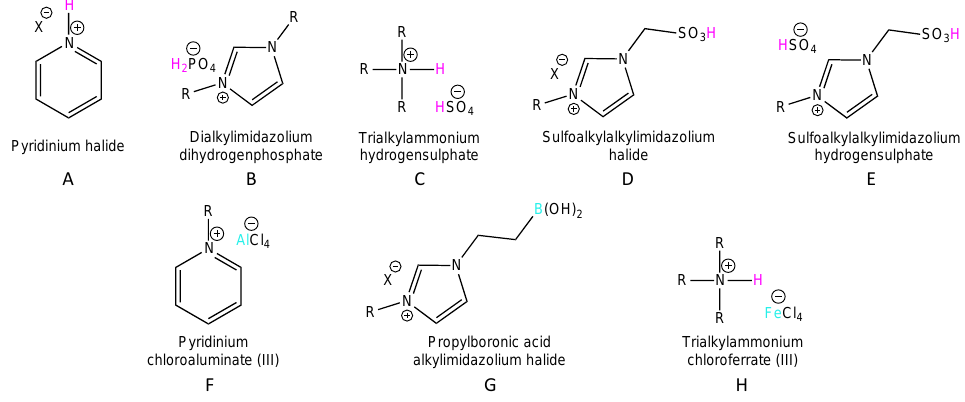
Figure 1. Examples of the structures of some acidic ionic liquids.